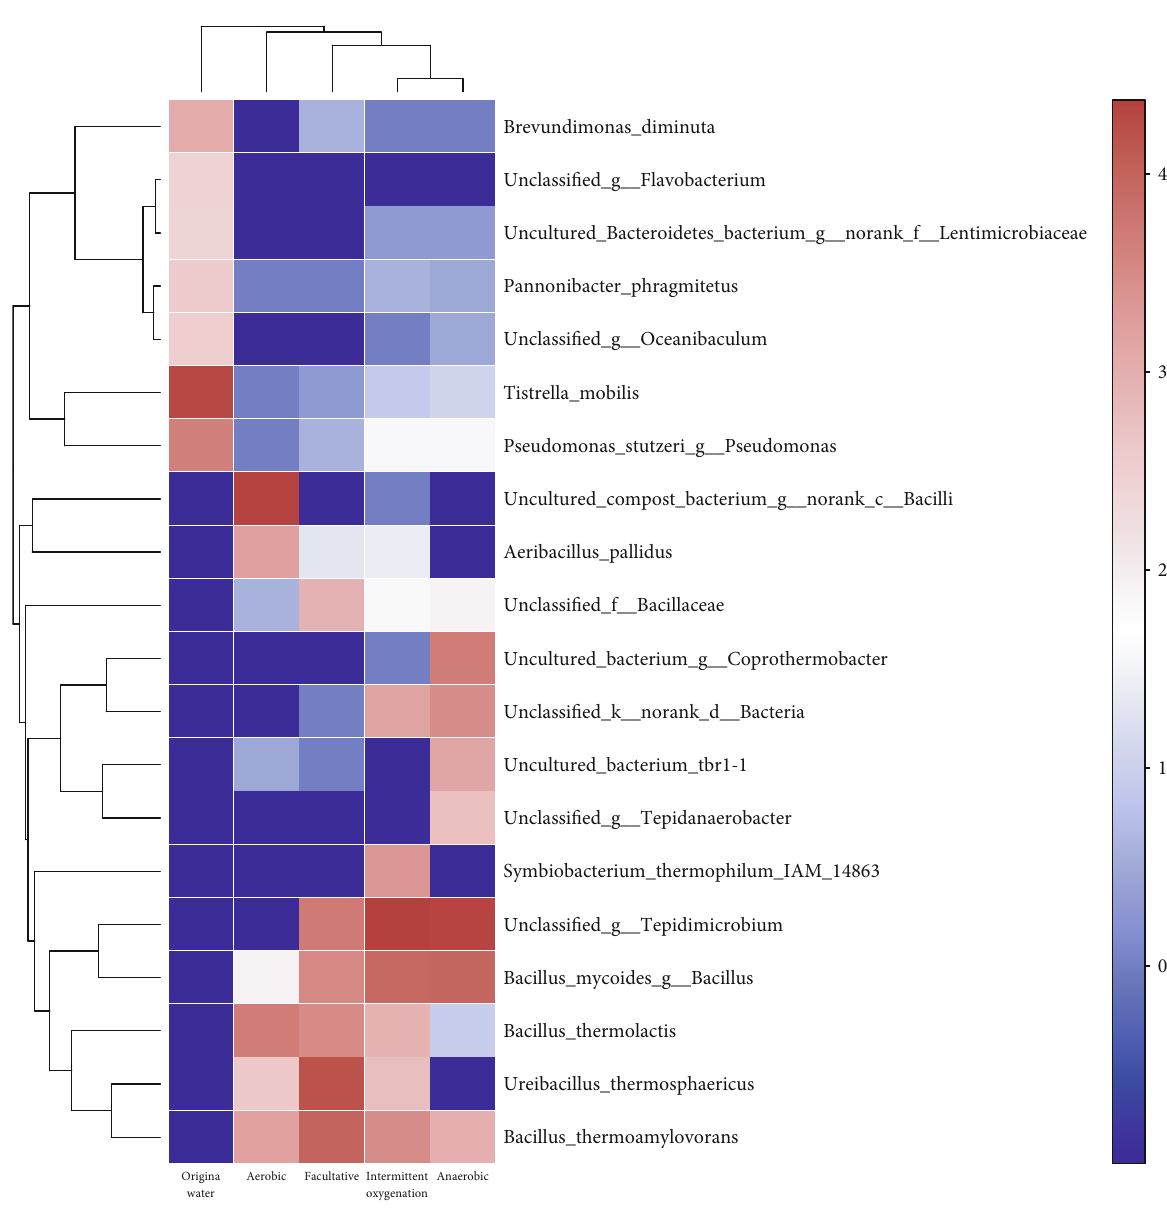
Figure 6: Species composition of microbial communities in di ff erent